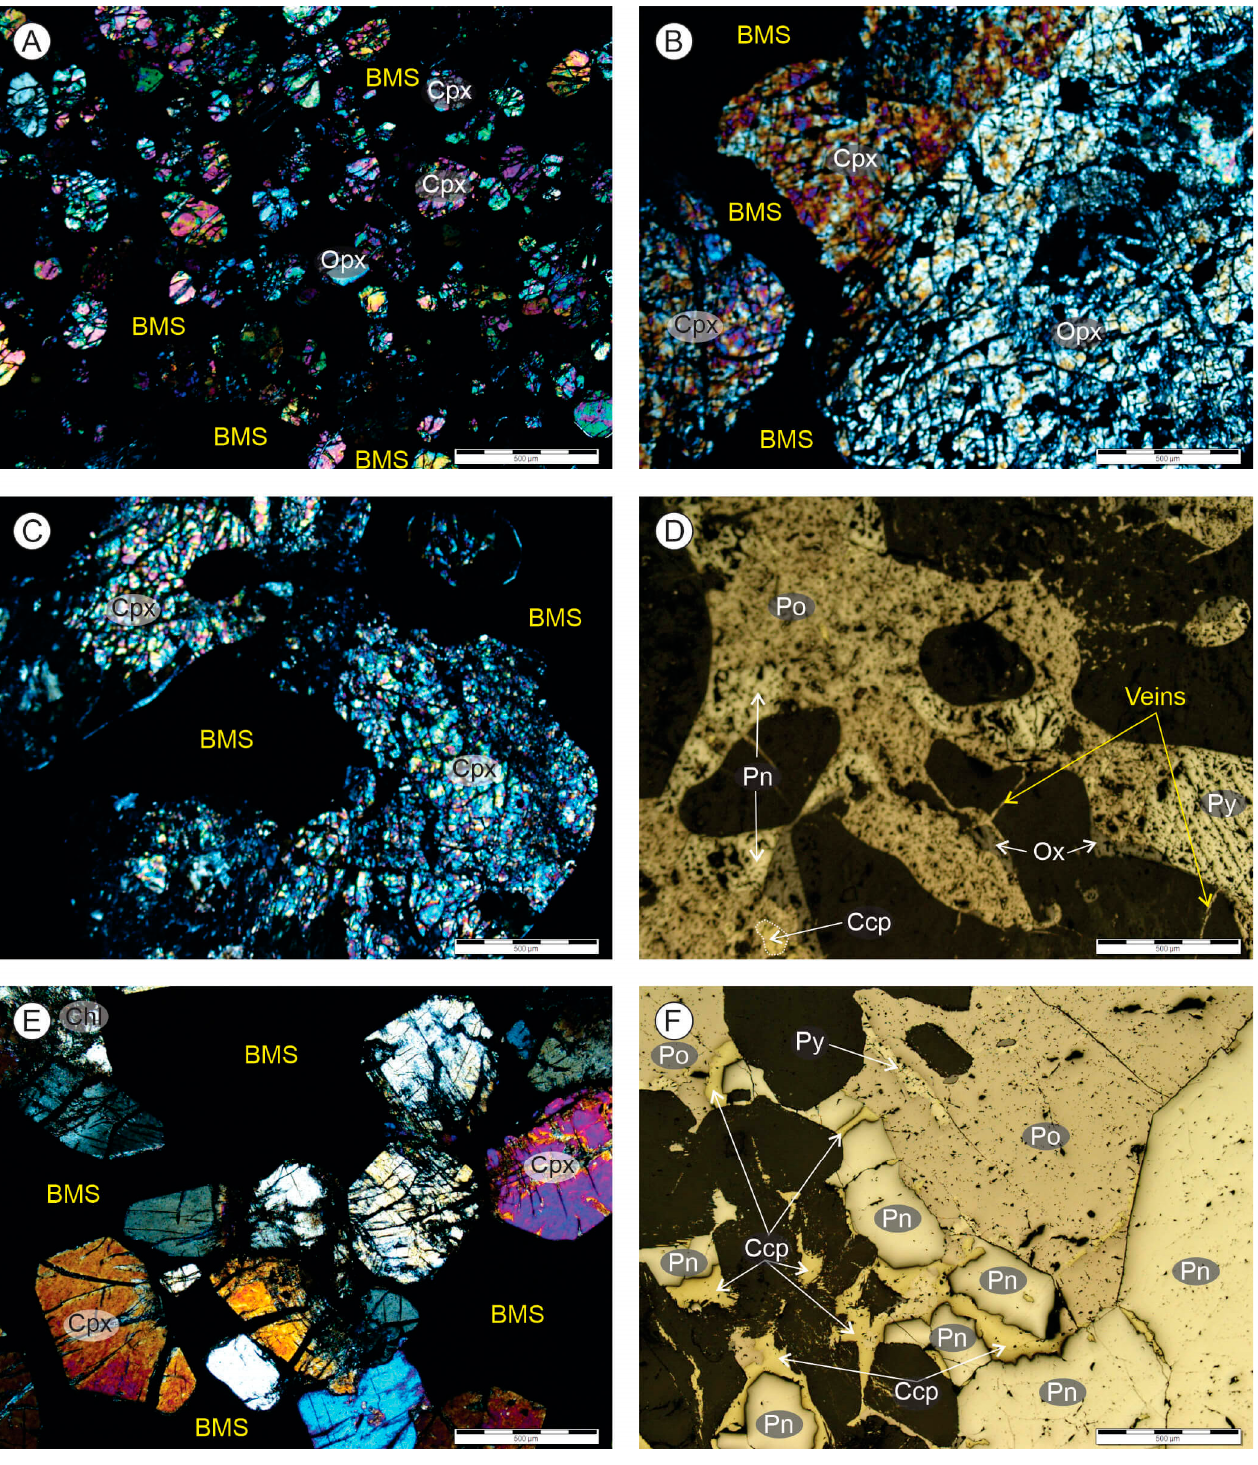
Figure 5. Photomicrographs of the high-grade semi-massive ( A – C ) and medium-grade semi-massive ( D – F ) sulfide ores show various silicates and sulfides. The scale bar at the bottom right corner of the images represents 500 µm. Refer to Figure 2 for explanation of the mineral abbreviations.